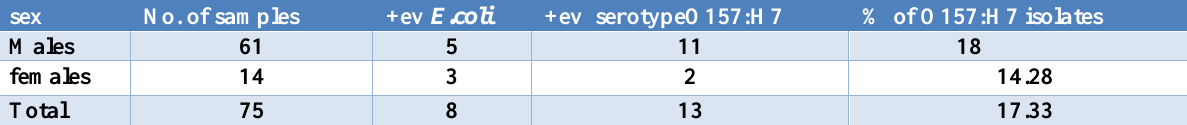
Table, 2: Showed number of urine samples from male and female sheep with percentage of E.coli O157:H7